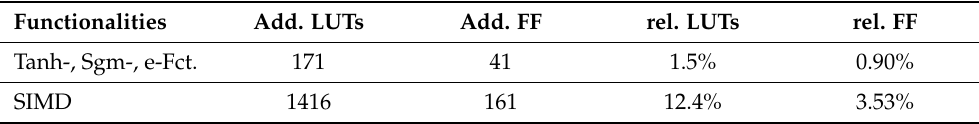
Table 5. Resources needed for the additional hardware on the FPGA. The relative values are referring to the AIRISC without the FPU, accordingly 11,350 LUTs and 4557 FFs.